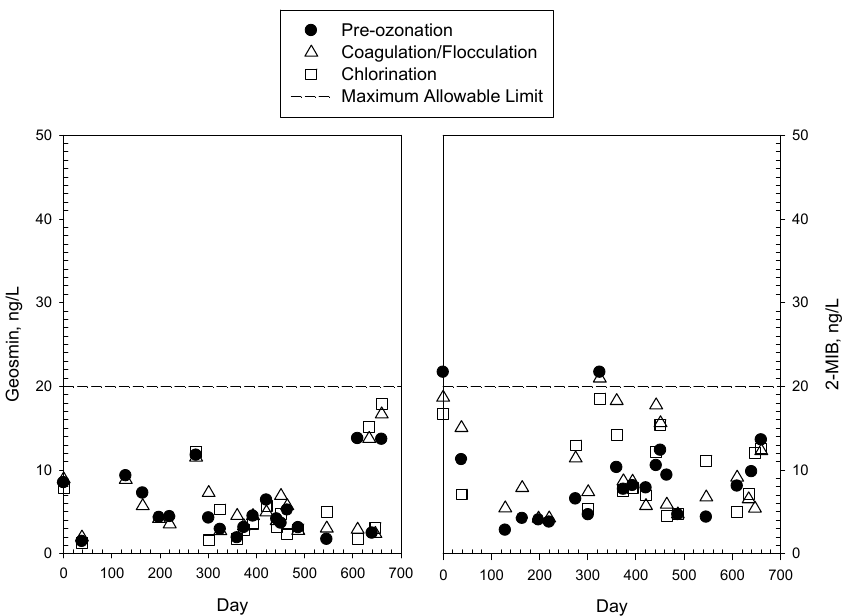
Figure 4. Concentrations of geosmin and 2-MIB affected by the coagulation/flocculation and chlorination processes.